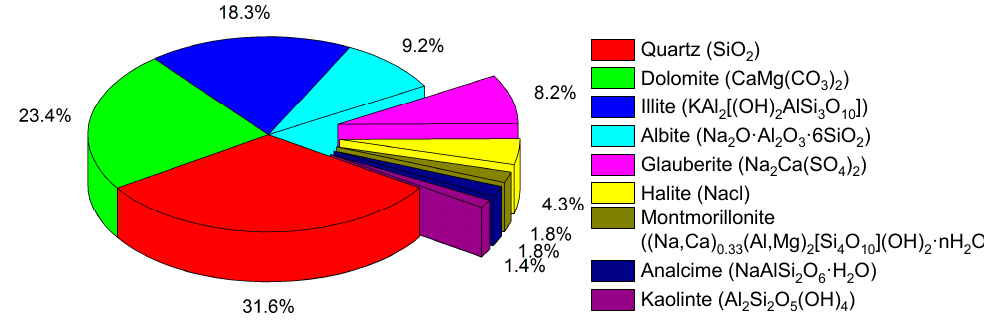
Figure 2. XRD results of mudstone.